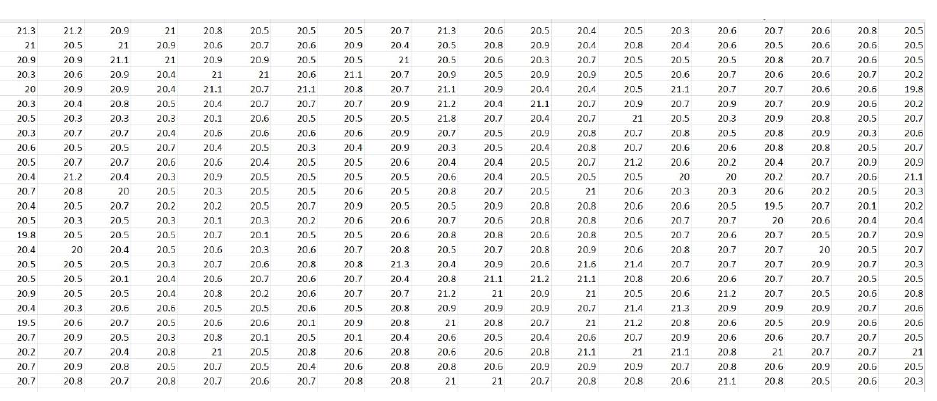
Figure 4. Example of temperature value matrix in a spreadsheet. Here, part of the temperature matrix of a thermal image is displayed: each cell represent the temperature in °C of a single pixel of the image.